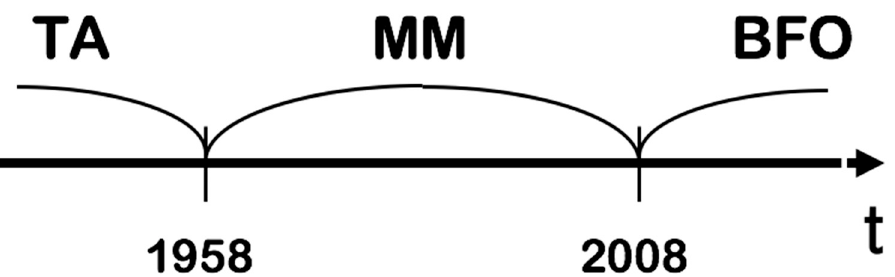
Figure 1. Historical aspects of capital cost and capital structure theory: here empirical traditional approach—TA, Modigliani–Miller theory—MM, Brusov–Filatova–Orekhova theory—BFO.